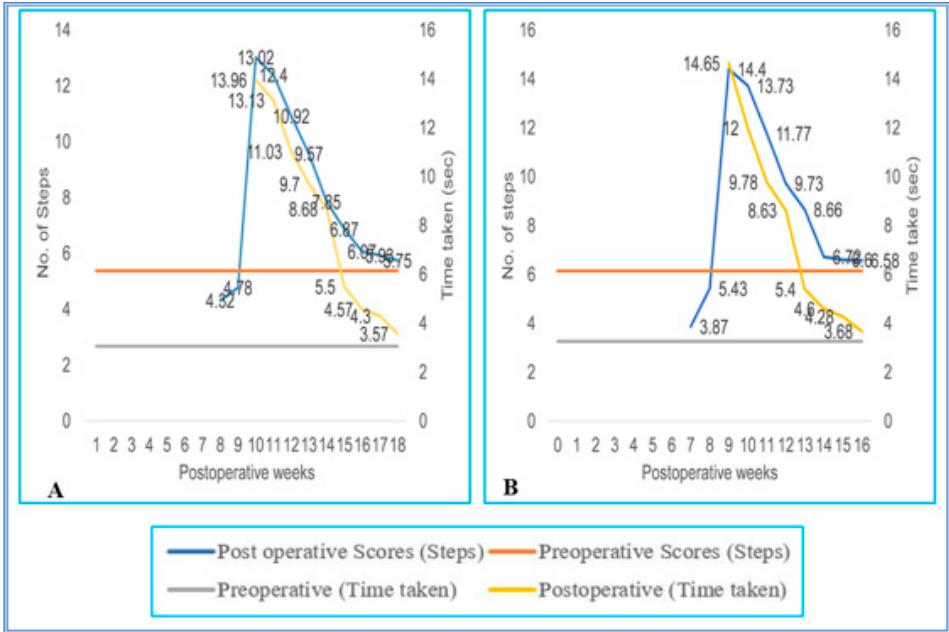
Figure 6. ( A , B ) Evaluation of locomotor behavior in staircase test after SPC hemisection plus predegenerated peripheral nerve transplantation in Bonnet monkey ( Macaca radiata ) on staircase runway. Primary X-axis represents duration of recovery of locomotor functions in terms of weeks; primary Y-axis and secondary Y-axis represent the number of steps and time taken by the spinal cord unilateral hemisection plus predegenerated peripheral nerve transplantation monkeys to climb up/down the staircase.